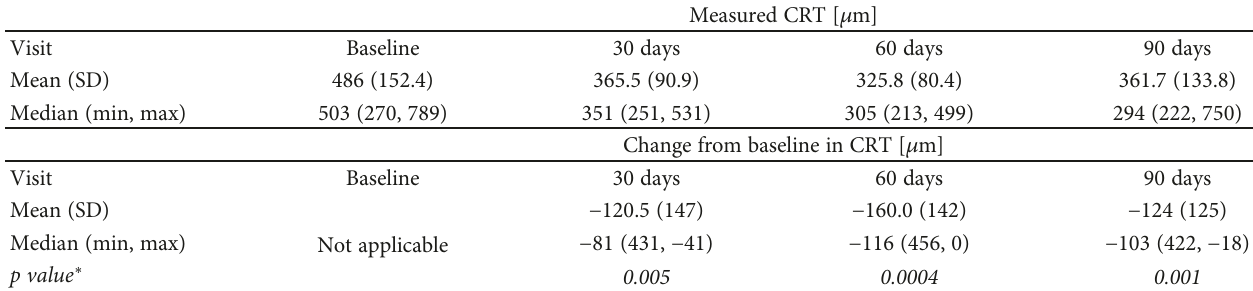
Table 2: Central retinal thickness (CRT) over time.